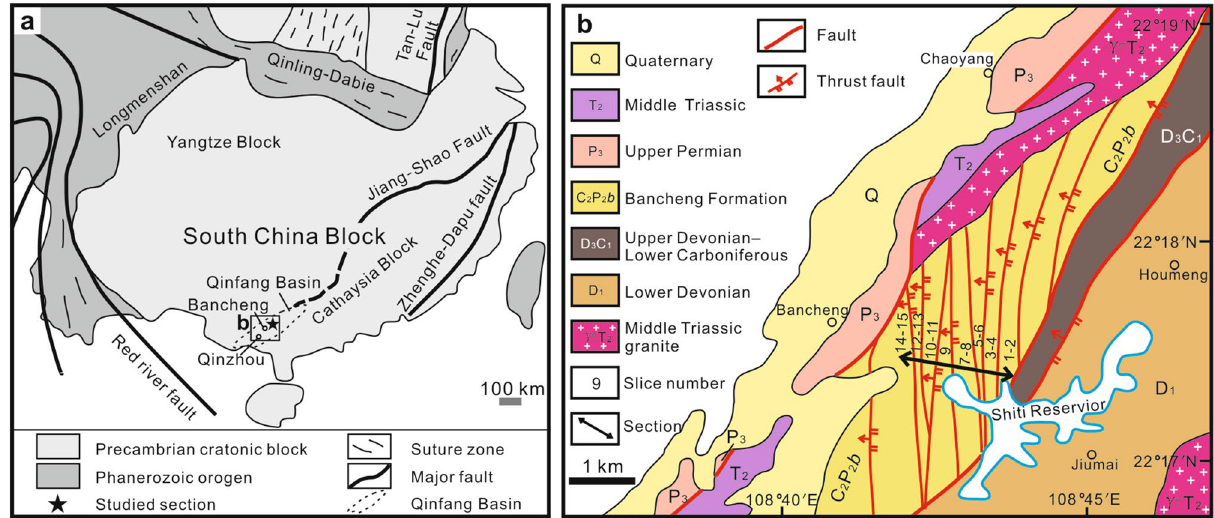
Figure 1. ( a ) Tectonic map of South China (revised after Zheng et al 13 ) and location of the studied section. ( b ) Geological map of the studied area (revised after Ke et al 14 ). Y.F.X. created this figure using CorelDRAW X4 (https:// www. corel draw. com/ en/ pages/ corel draw-